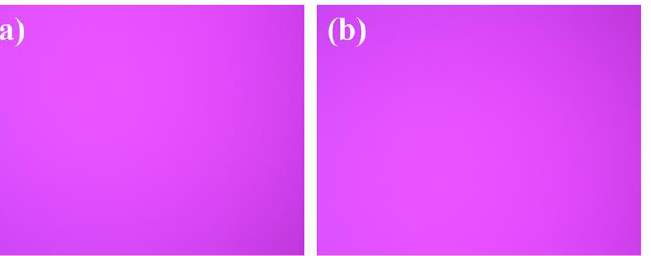
Figure 7. Microemulsion of AGO/Tween ® 20/PG/water system was isotropic under polarizing light microscope before ( a ) and after ( b ) the stability test under heating–cooling conditions. The magnification was 10×. 3.6. Cholinesterase Inhibition of AGO ME The IC 50 values of the AGO/Tween ® 20/PG/water system against AChE and BChE were compared with that of native AGO alone. Other components, Tween ® 20 and PG, were also investigated. The results are shown in Table 4. With equal concentrations of AGO (100 µg/mL), the inhibitory activities of ME were significantly higher than those of AGO alone against both AChE and BChE ( p < 0.05). Tween ® 20 and PG showed no inhibition against either enzyme. Therefore, it was considered that loading AGO in a monophasic ME system could greatly enhance the inhibition of the enzymes by increasing the aqueous solubility and compatibility with the test solution in Ellman’s assay, since the cholinesterase inhibitory activity of AGO was hindered due to the poor aqueous solubility. Table 4. Anticholinesterase activities of microemulsion formulation and each component. Formulation/Component